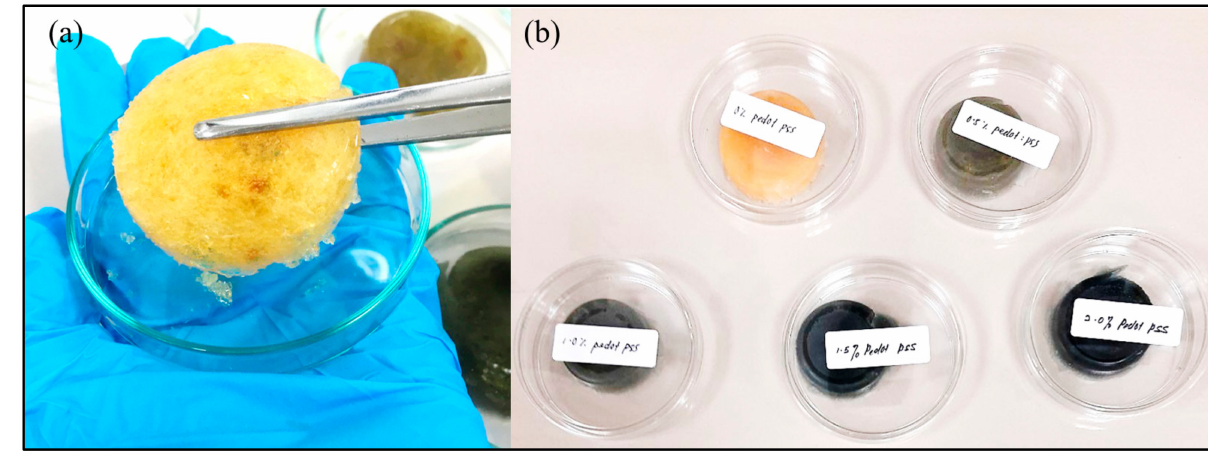
Figure 1. ( a ) Close-up image of porous hydrogel; ( b ) scaffold samples after removal of